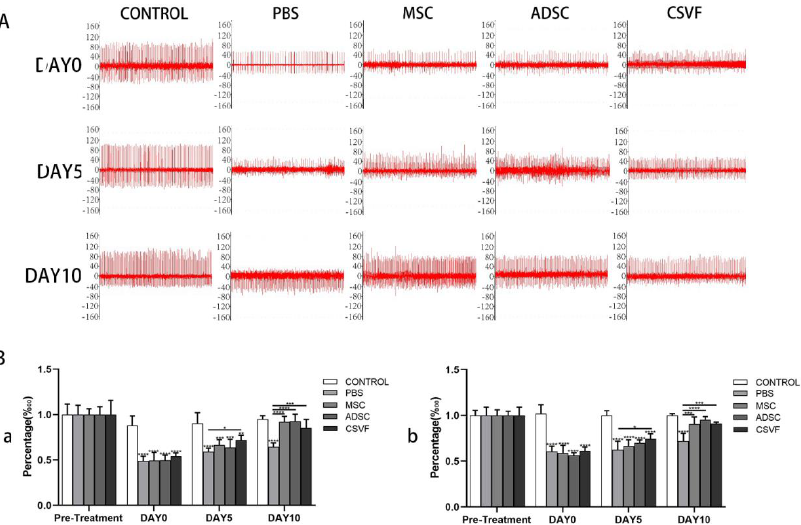
Figure 4. EMG of control, PBS, MSC, ADSC, CSVF groups after modeling and after 5 and 10 days of treatment. ( A ) The first row shows the EMG of control, PBS, MSC, ADC and CSVF groups after modeling, the second row shows the EMG of each group after 5 days of treatment, and the third row shows the EMG of each group after 10 days of treatment. ( B ) Percentage of EMG frequency (a), EMG peak (b) in different treatment groups normalized to pre-treatment healthy controls. Data in each bar graph are expressed as mean ± standard deviation. An **, *** or **** without a horizontal line indicates a statistical difference in comparison to the control group, and an *, *** or **** with a horizontal line indicates a statistical difference between the groups at the horizontal ends. Significant differences between groups were expressed as **** p < 0.0001, *** p < 0.001, ** p < 0.01, and * p <